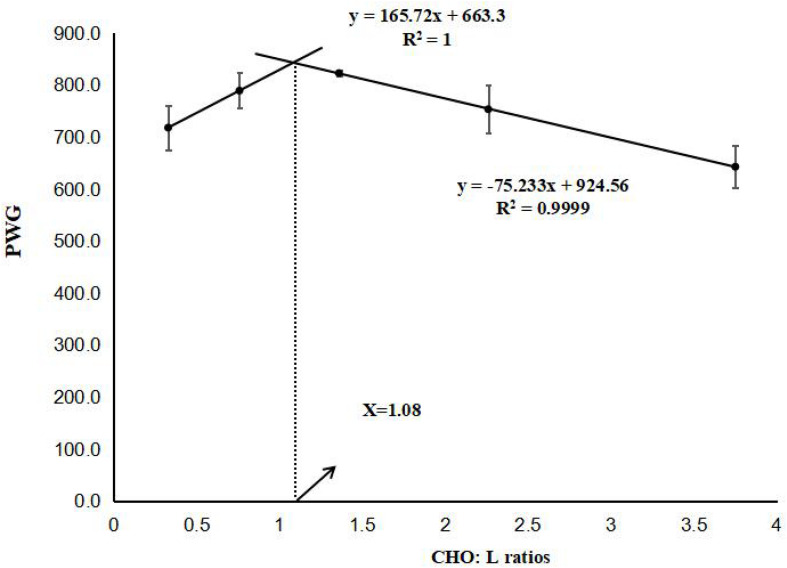
Relationship between percentage weight gain (PWG) and dietary (CHO:L) ratios based on two-slope, broken-line regression analysis, where Xopt represents the optimal dietary (CHO:L) ratio for the maximum PWG of black seabream.